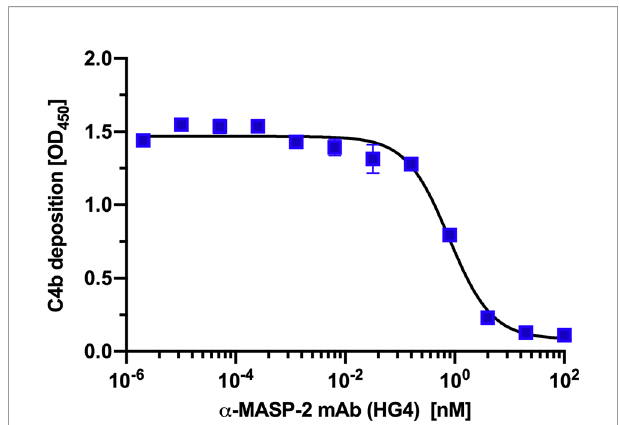
FIGURE 3 | HG4 inhibits lectin pathway mediated C4b deposition. A microtiter ELISA plate was coated with mannan and blocked with BSA. Different concentrations of HG4 antibody were mixed with 2% NHS and incubated on the plate. Bound C4b was detected using anti C4c